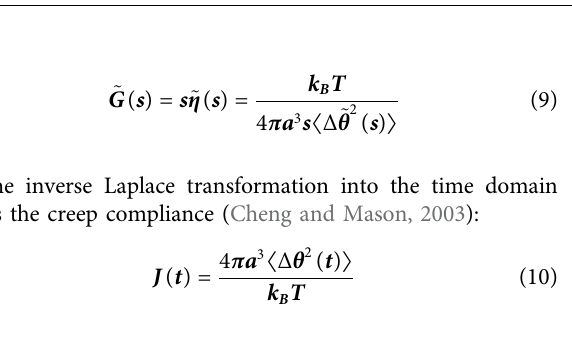
Frontiers in Bioengineering and Biotechnology |